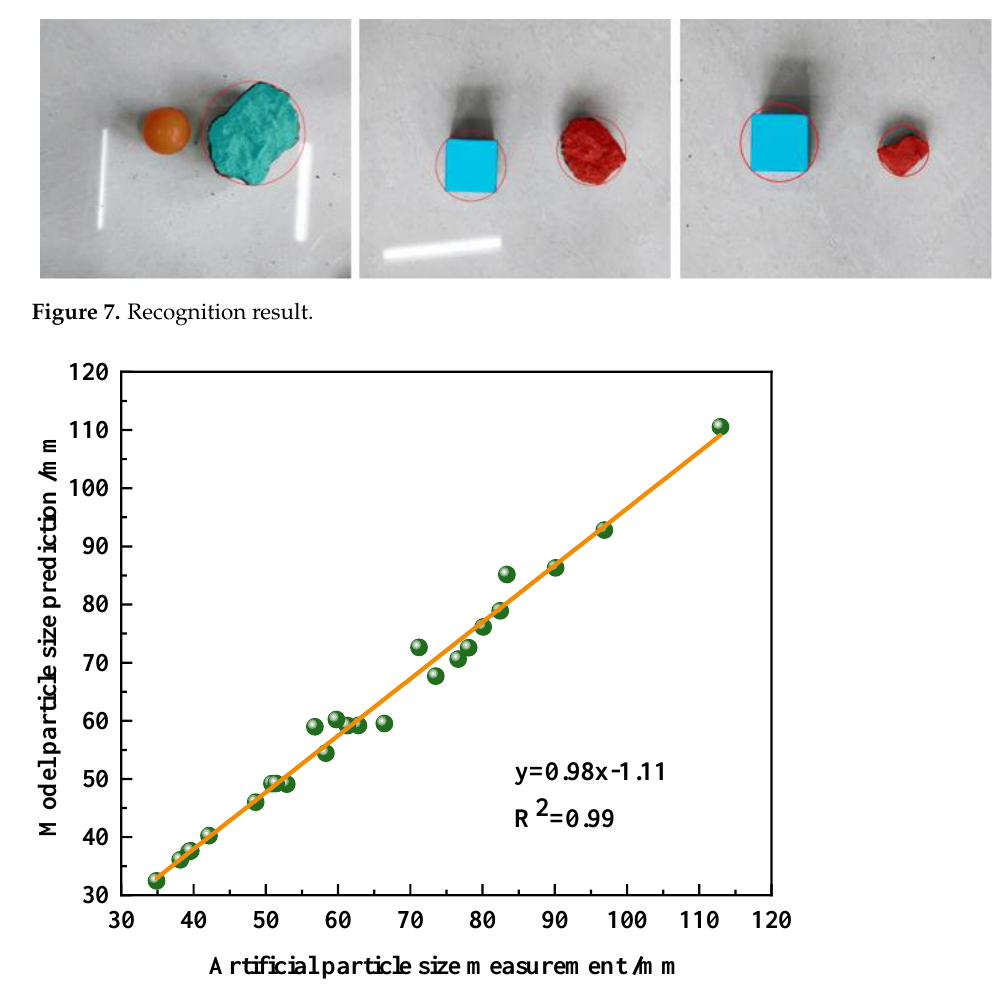
Figure 8. Correlation analysis between manual measurement value and model detection value of soil block particle size.